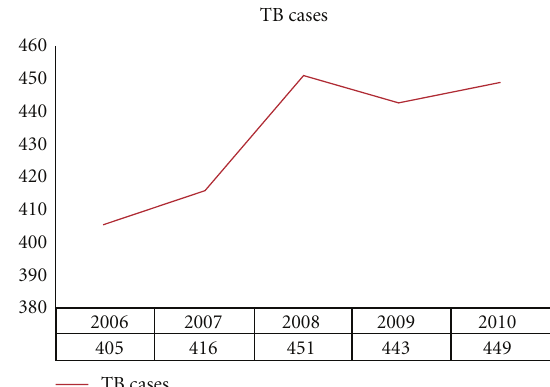
Figure 2: Frequency of TB cases in the State of Mexico during the years 2006 to